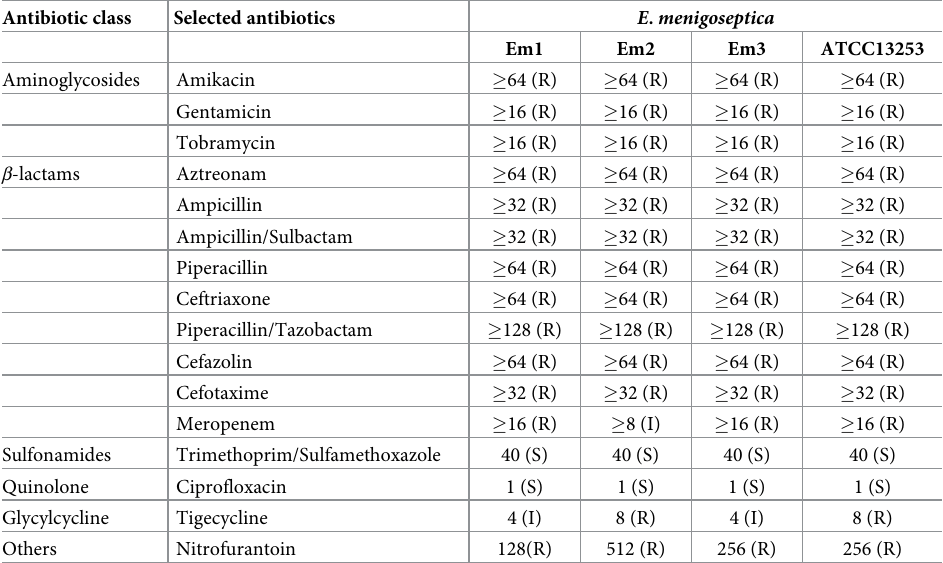
Table 3. Antibiotic susceptibility test (AST) in the selected E . menigoseptica . Antibiotic class Selected